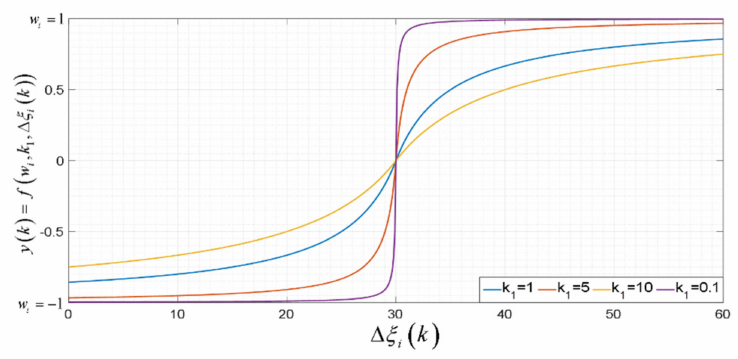
Figure 5. Saturation matrix W (.) as a function of control error ∆ ξ ( k )